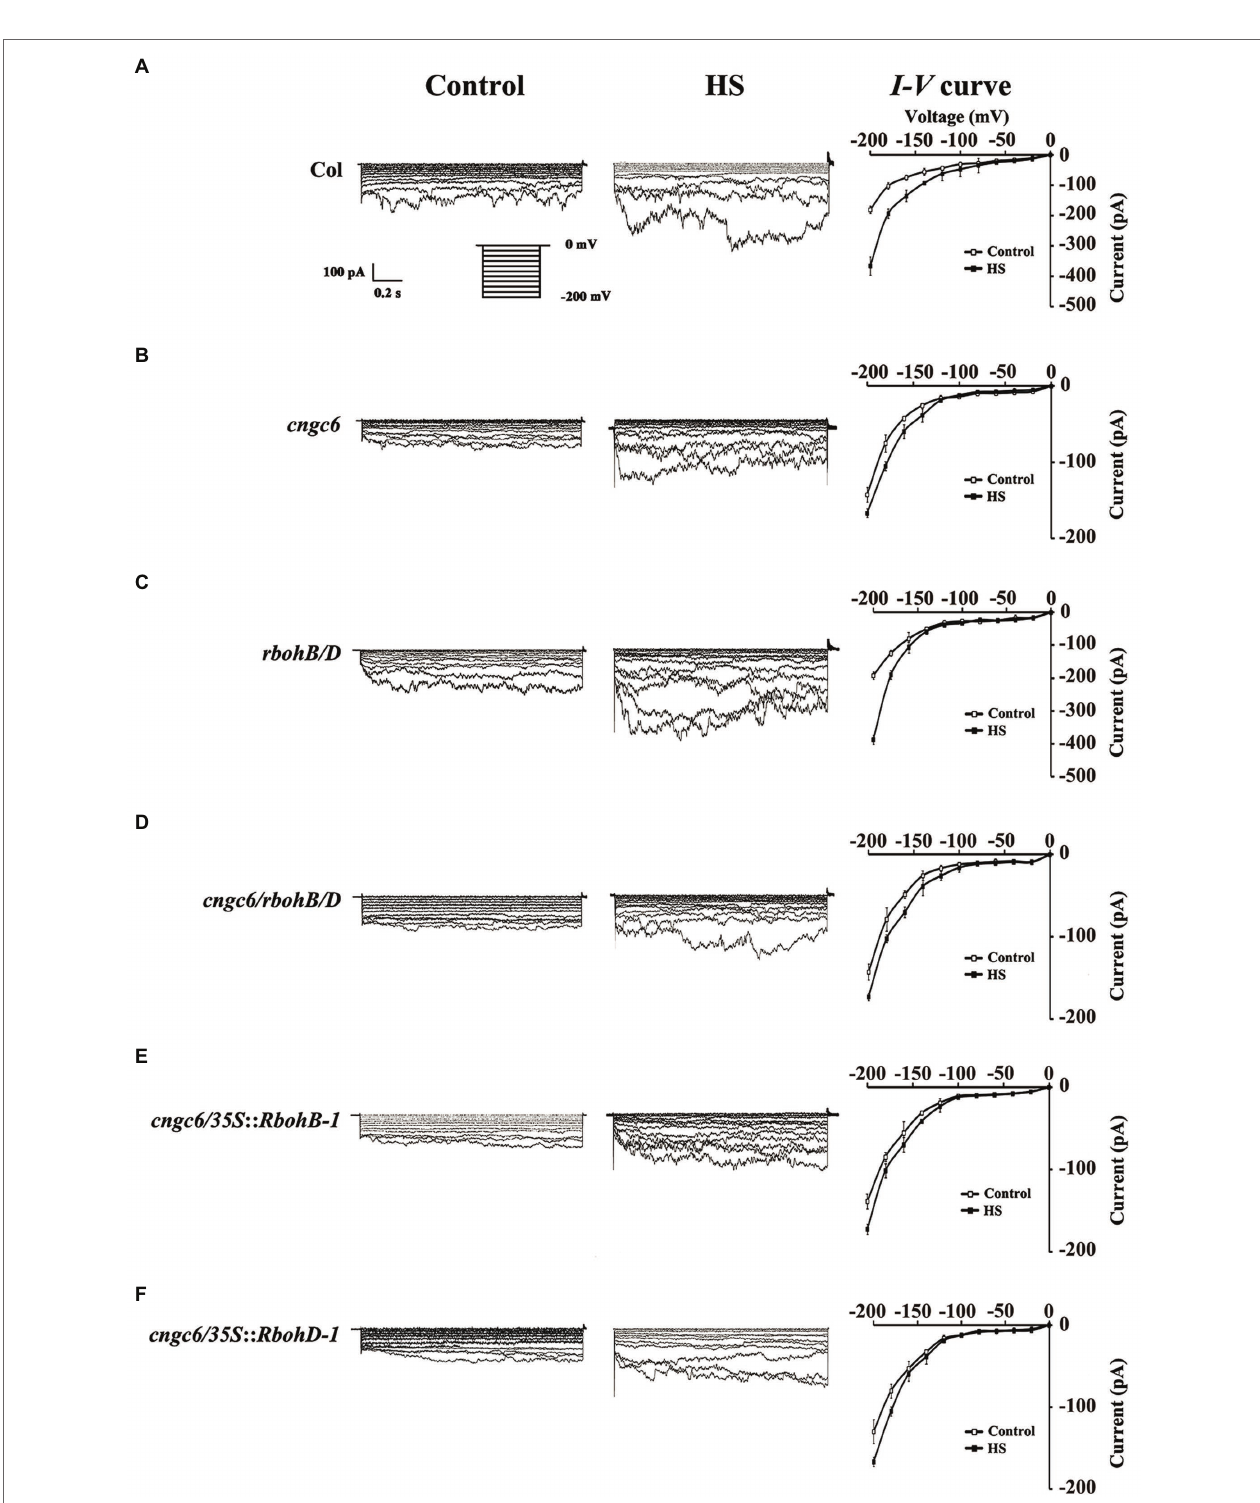
FIGURE 6 | Patch-clamp analysis of Ca 2+ -permeable channels in wild-type, cngc6 , rbohB/D , cngc6/rbohB/D , cngc6 / 35S :: RbohB-1 , and cngc6 / 35S :: RbohD-1 seedlings. The Ca 2+ current before HS (at 22 ° C, control) and after HS (at 37 ° C, HS) was compared in the root cell protoplasts of 8-day-old wild-type (A) , cngc6 (B) , rbohB/D (C) , cngc6/rbohB/D (D) , cngc6 / 35S :: RbohB-1 (E) , and cngc6 / 35S :: RbohD-1 (F) plants. The Ca 2+ current was recorded by step voltage clamp. Each trace is a representative current from six protoplasts. Currents in the protoplasts are shown in the left and middle columns, respectively. The I–V curve is shown in the right column (mean ± SD, n =